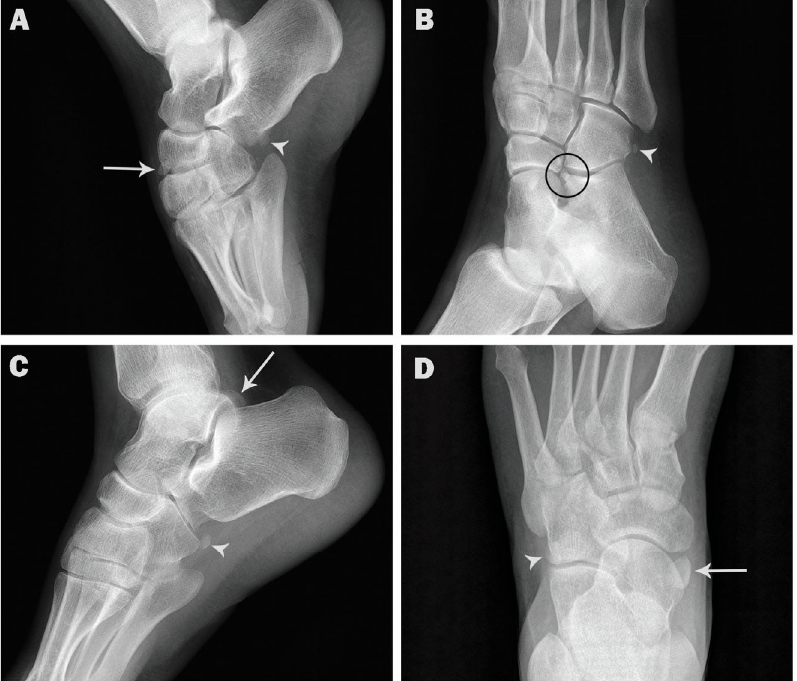
Figure 3. Coexistence of os peroneum and other ossicles in the same foot. ( A ). Lateral radiograph showing os peroneum (arrowhead) and os infranaviculare (arrow) in a 31-year-old female. ( B ). Oblique radiograph showing os peroneum (arrowhead) and os calcaneus secundarius (circle) in a 52-year-old female. ( C ). Lateral radiograph showing os peroneum (arrowhead) and os trigonum (arrow) in a 48-year-old male. ( D ). AP radiograph showing os peroneum (arrowhead) and accessory navicular (arrow) in a 55-year-old male.